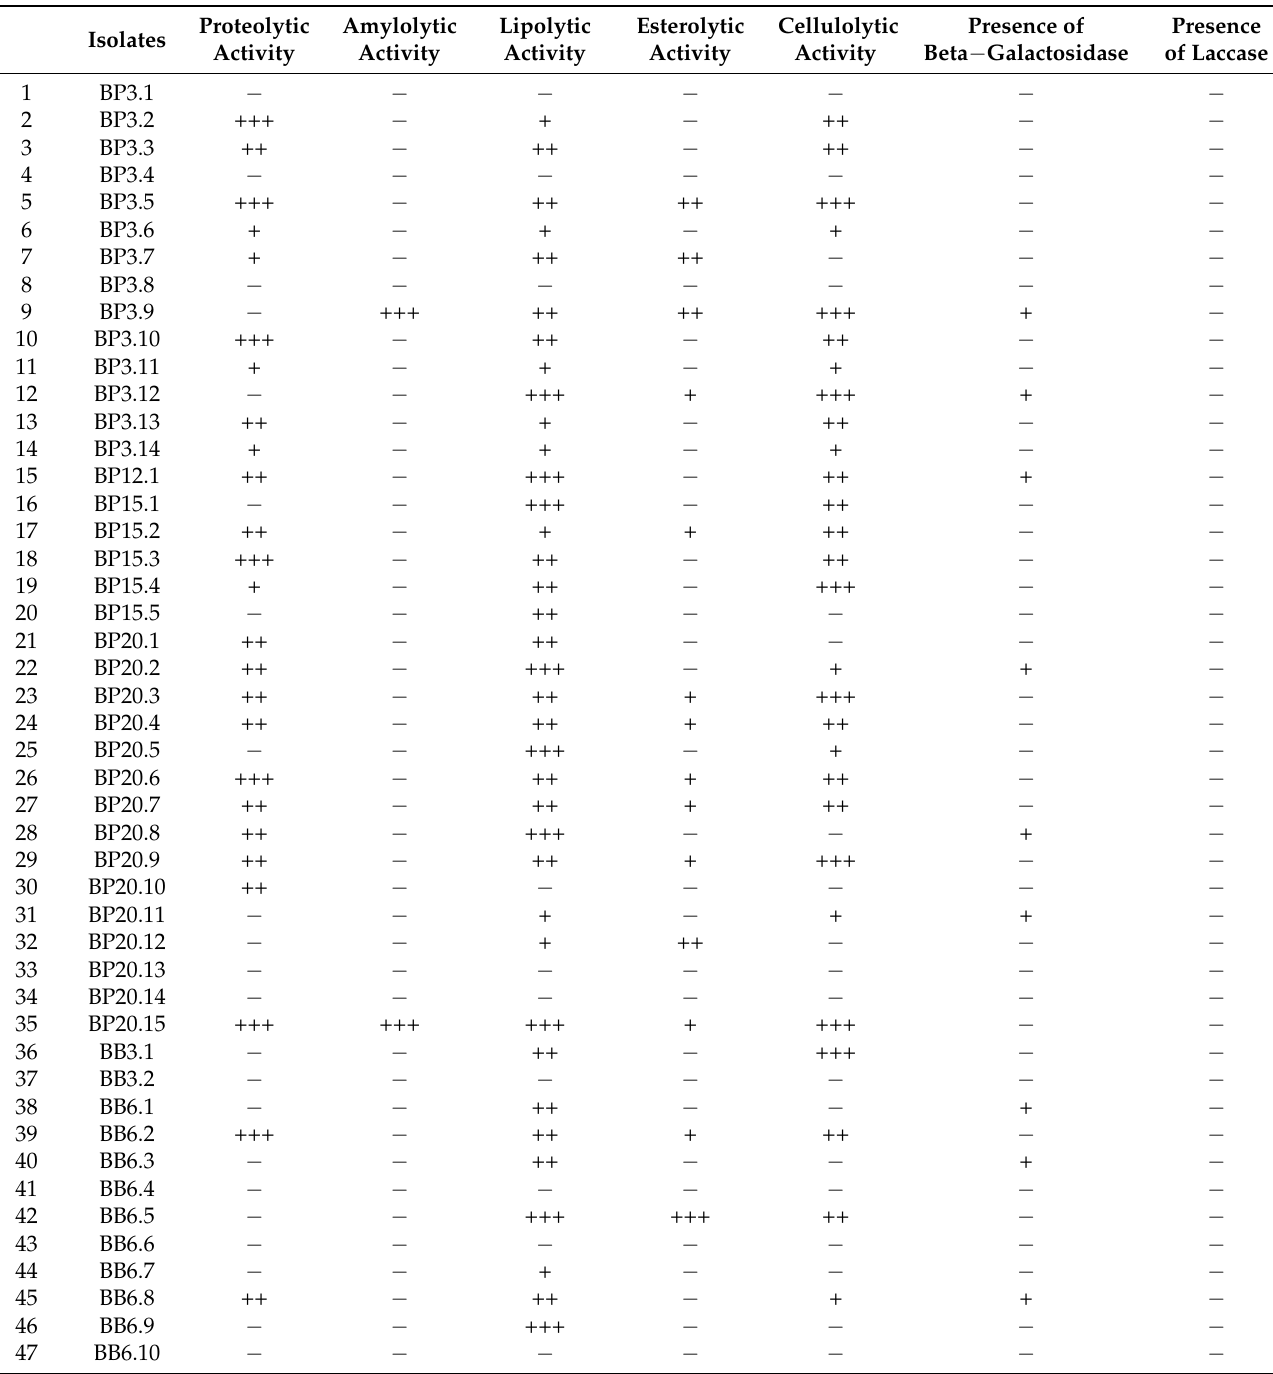
Table 3. Enzymatic activity of